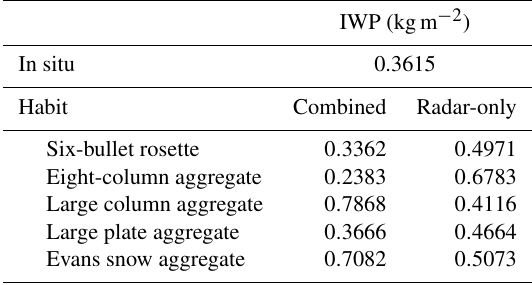
Table 4. Retrieved IWP along in situ flight path for flight B984 for the combined and radar-only